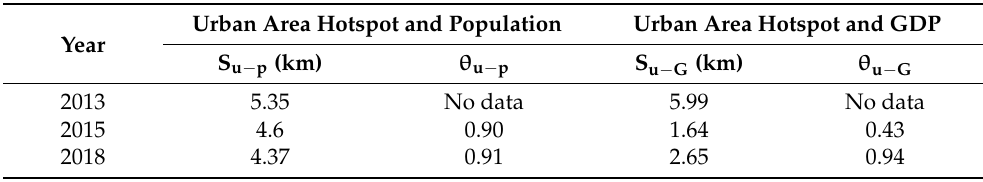
Table 3. Space-overlaps (S) and changes in consistency ( θ ) of city-level urban area hotspot and population and GDP gravity center.